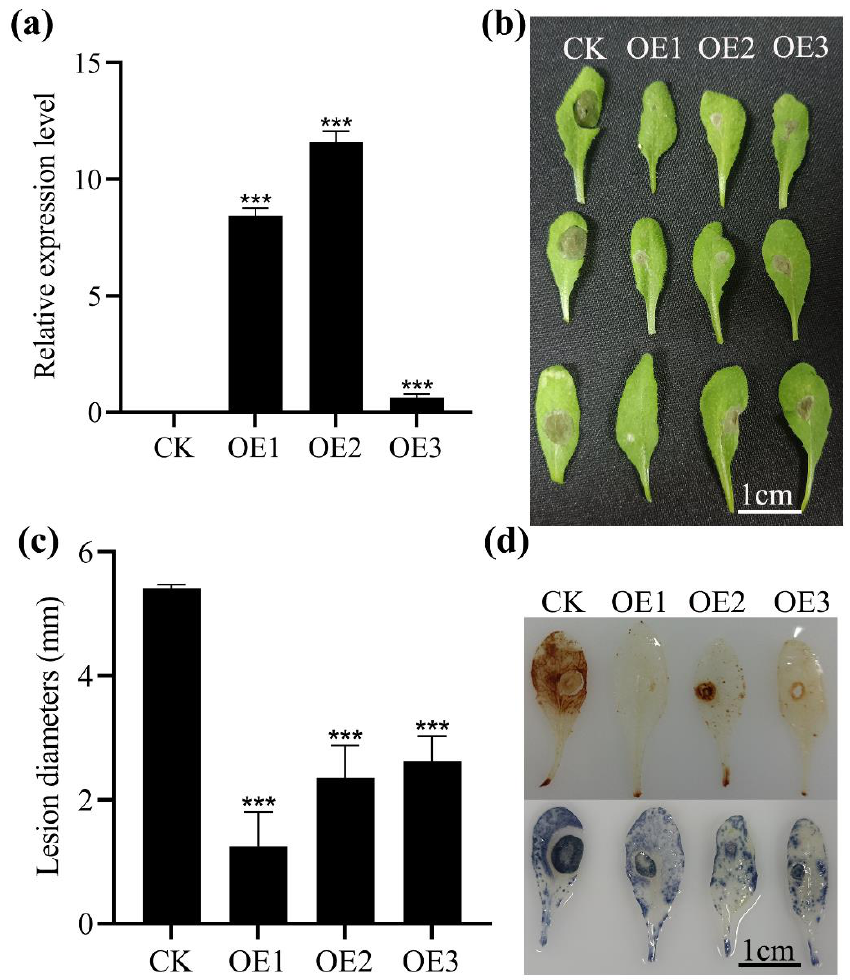
Figure 5. Resistance analysis of transgenic Arabidopsis to B. cinerea . ( a ) Relative expression levels of MnASI1 in transgenic Arabidopsis . CK, empty vector transgenic; OE, MnASI1 transgenic. ( b ) Ara- bidopsis leaves were photographed 36 h after infection with B. cinerea . ( c ) Quantitative analysis of resistance to B. cinerea in transgenic Arabidopsis . ( d ) DAB and NBT staining showed H 2 O 2 and O 2 − levels, respectively. Error bars represent standard deviation, n = 3 (*** p -value < 0.001; two-tailed t - test).